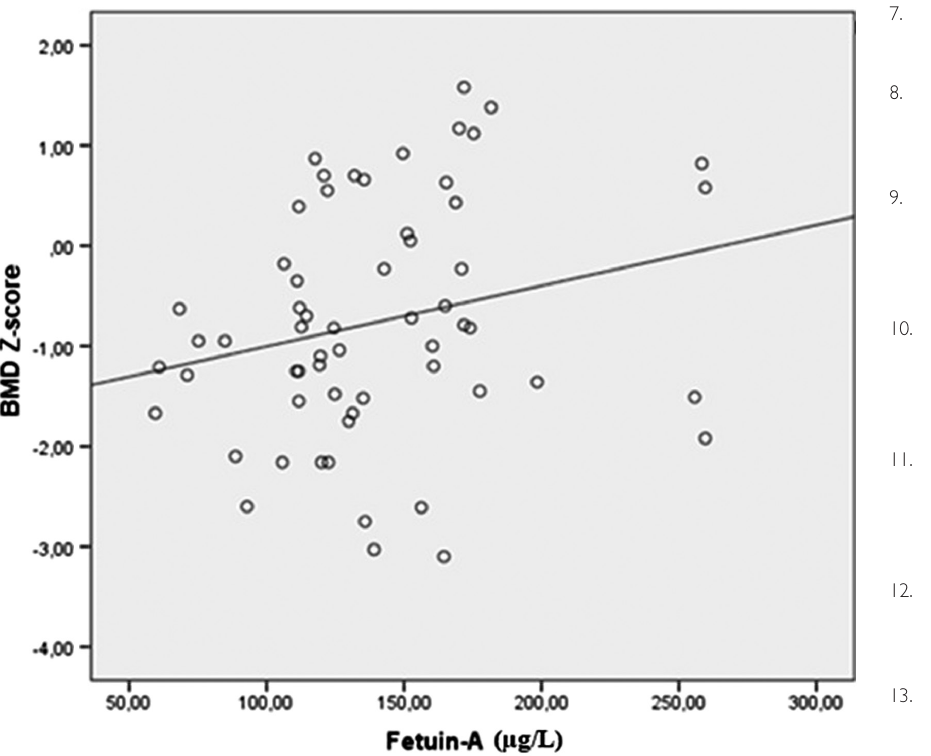
Figure 2. Correlation between Fetuin-A level and BMD Z-score in patient ( r = 0.257, P <